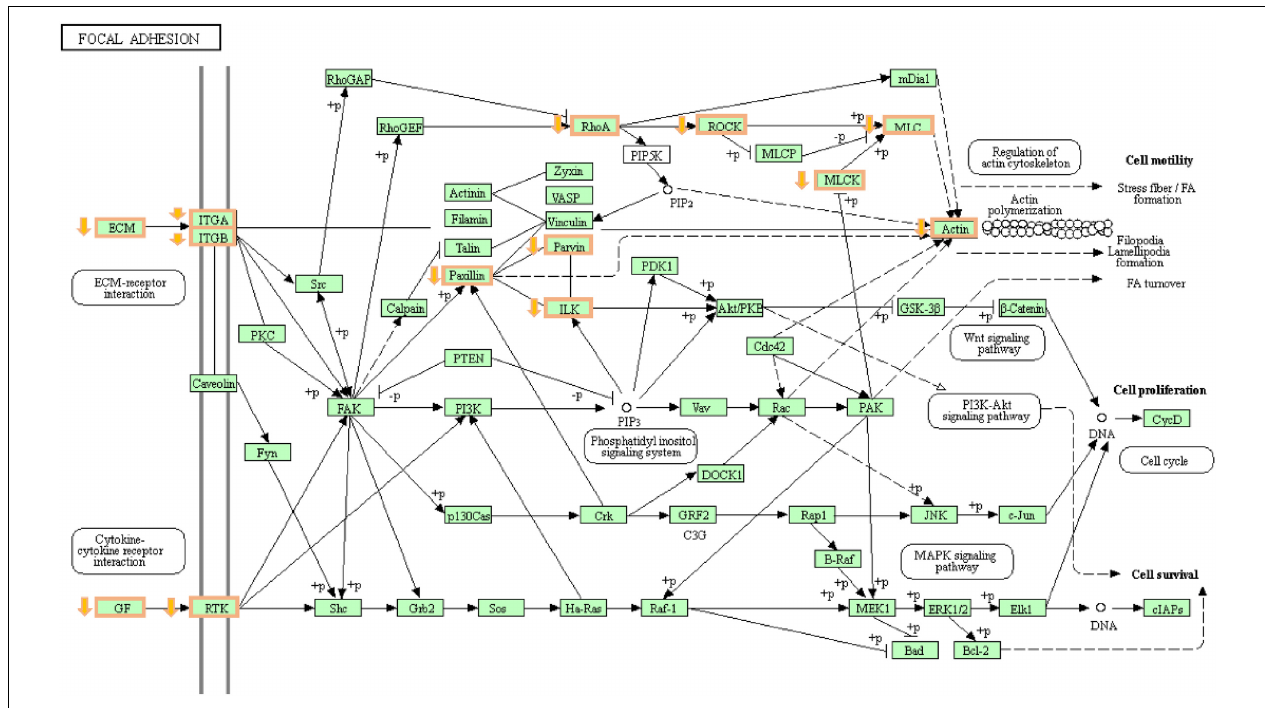
FIGURE 6 | The changes of focal adhesion pathways during hypoxic stress 8 h. Orange boxes are genes with decreased